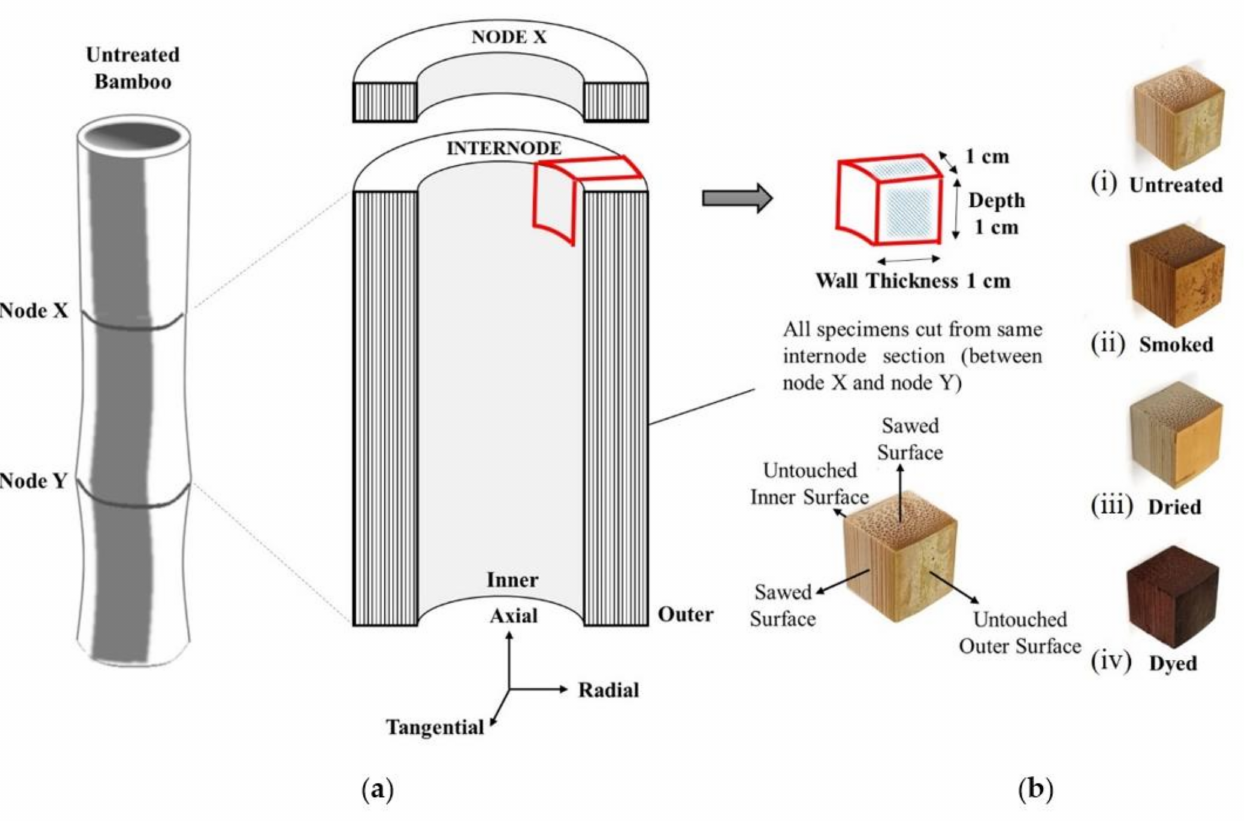
Figure 1. ( a ) Schematic illustration of specimen sizing; ( b ) types of bamboo used in this study: (i) untreated, (ii) smoked, (iii) naturally dried, and (iv)